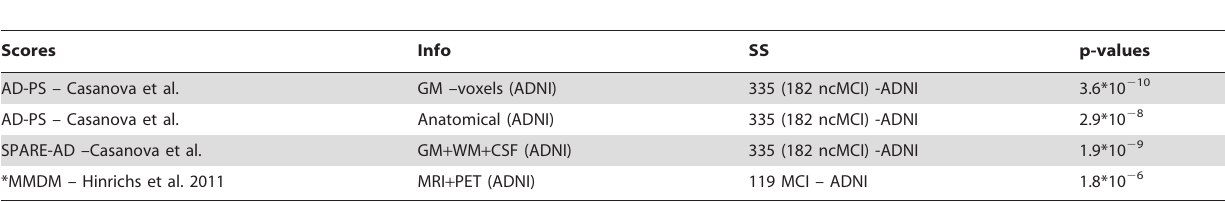
Table 10. Results related to detection of differences between ncMCI from cMCI ADNI participants based on statistical testing and imaging